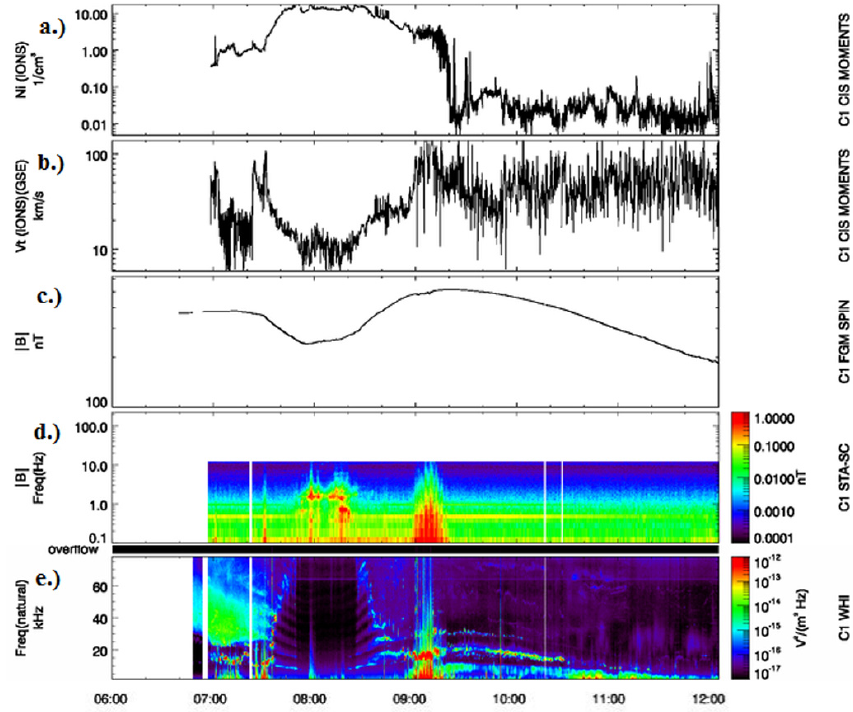
Fig. 1. Plasmapause crossing on 30 March 2002 as viewed from Cluster 1. Graphs, from top to bottom, show (a) energetic ion density recorded by CIS, (b) ion velocity from CIS, (c) magnetic field strength from FGM, (c) magnetic field waveform spectra from STAFF and (d) electric field waveform spectra from WHISPER. The inbound crossing is at 07:30, and the outbound crossing is at 08:45UTC. EMIC waves can be seen on STAFF, the fourth panel from 08:00 until